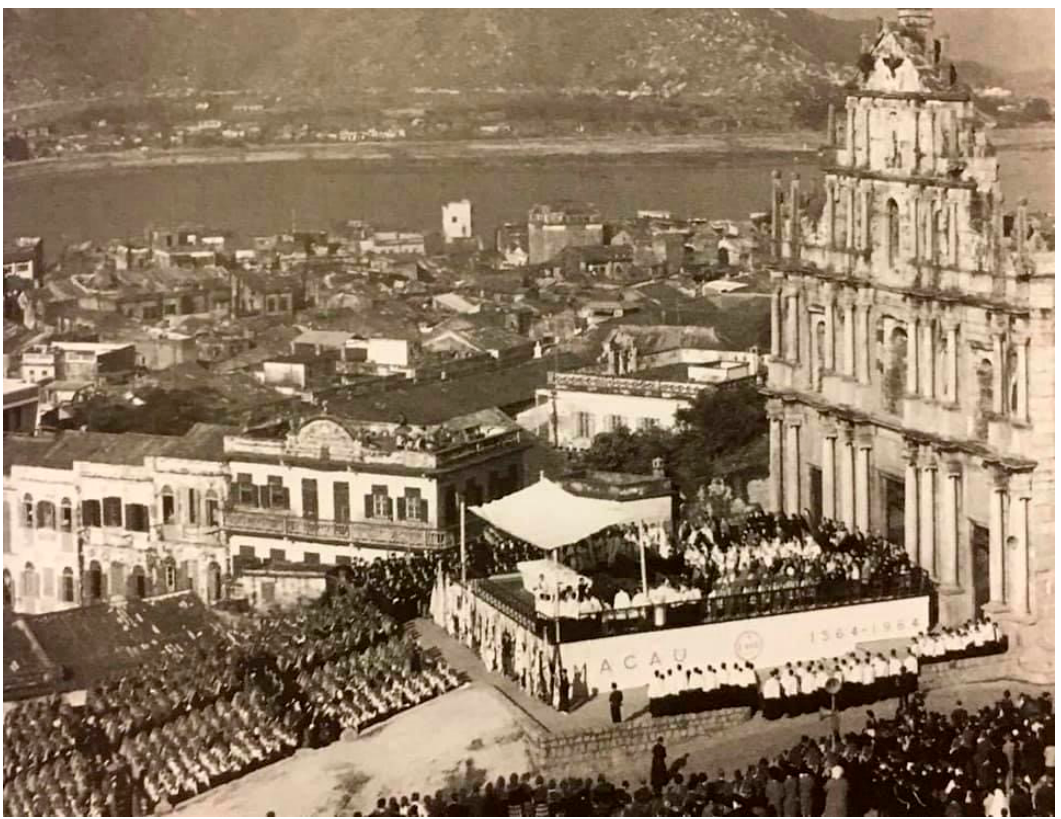
Figure 1. Mass to celebrate the 400th Anniversary of the Jesuits in Macao before the Ruins of St Paul’s Church, 1964 (image courtesy of the Library of the University of Saint Joseph, Macao).